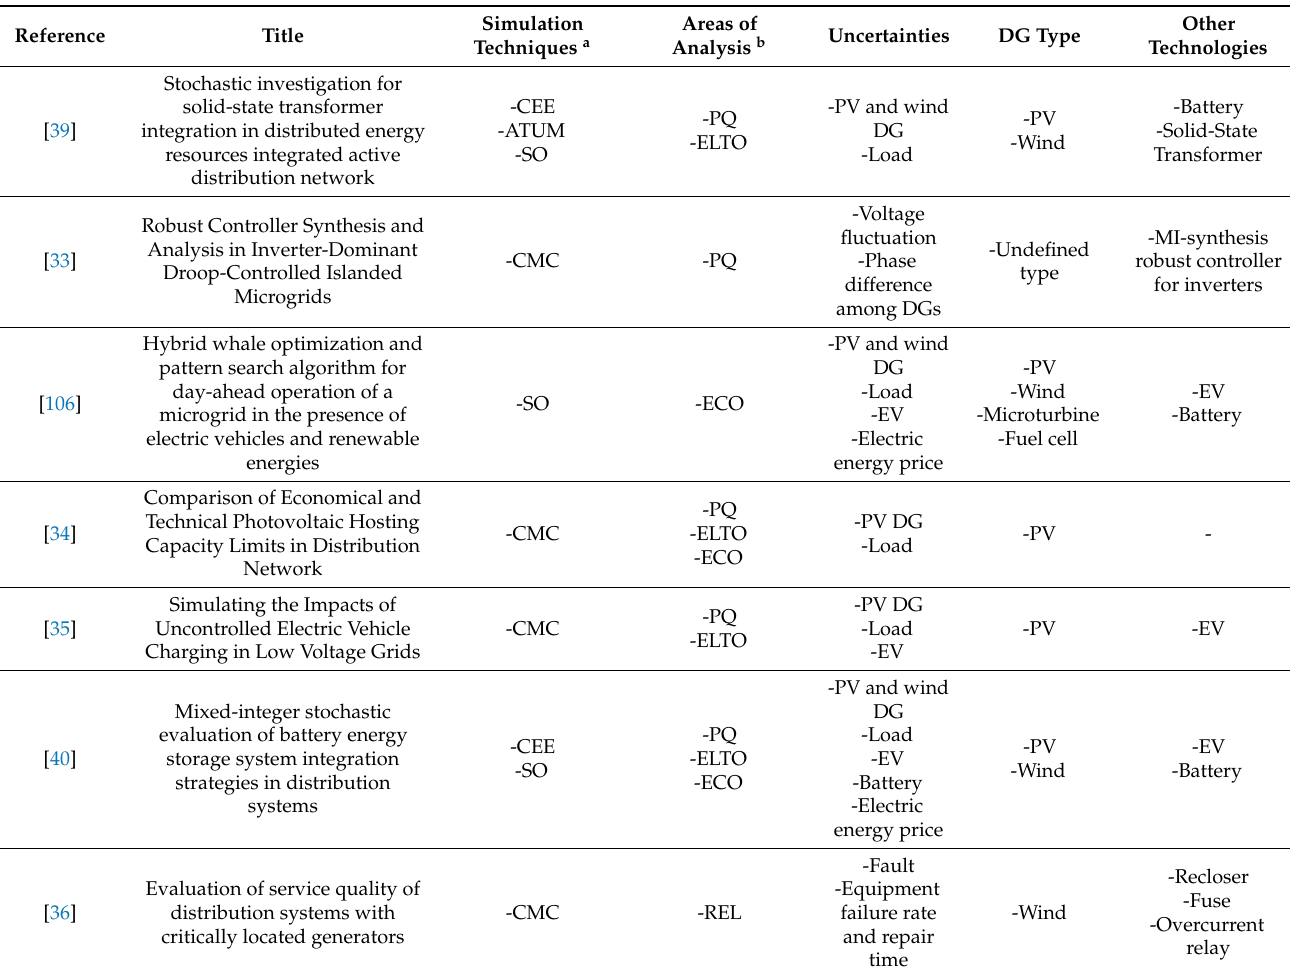
Table 3. Detailed classification of the reviewed papers from